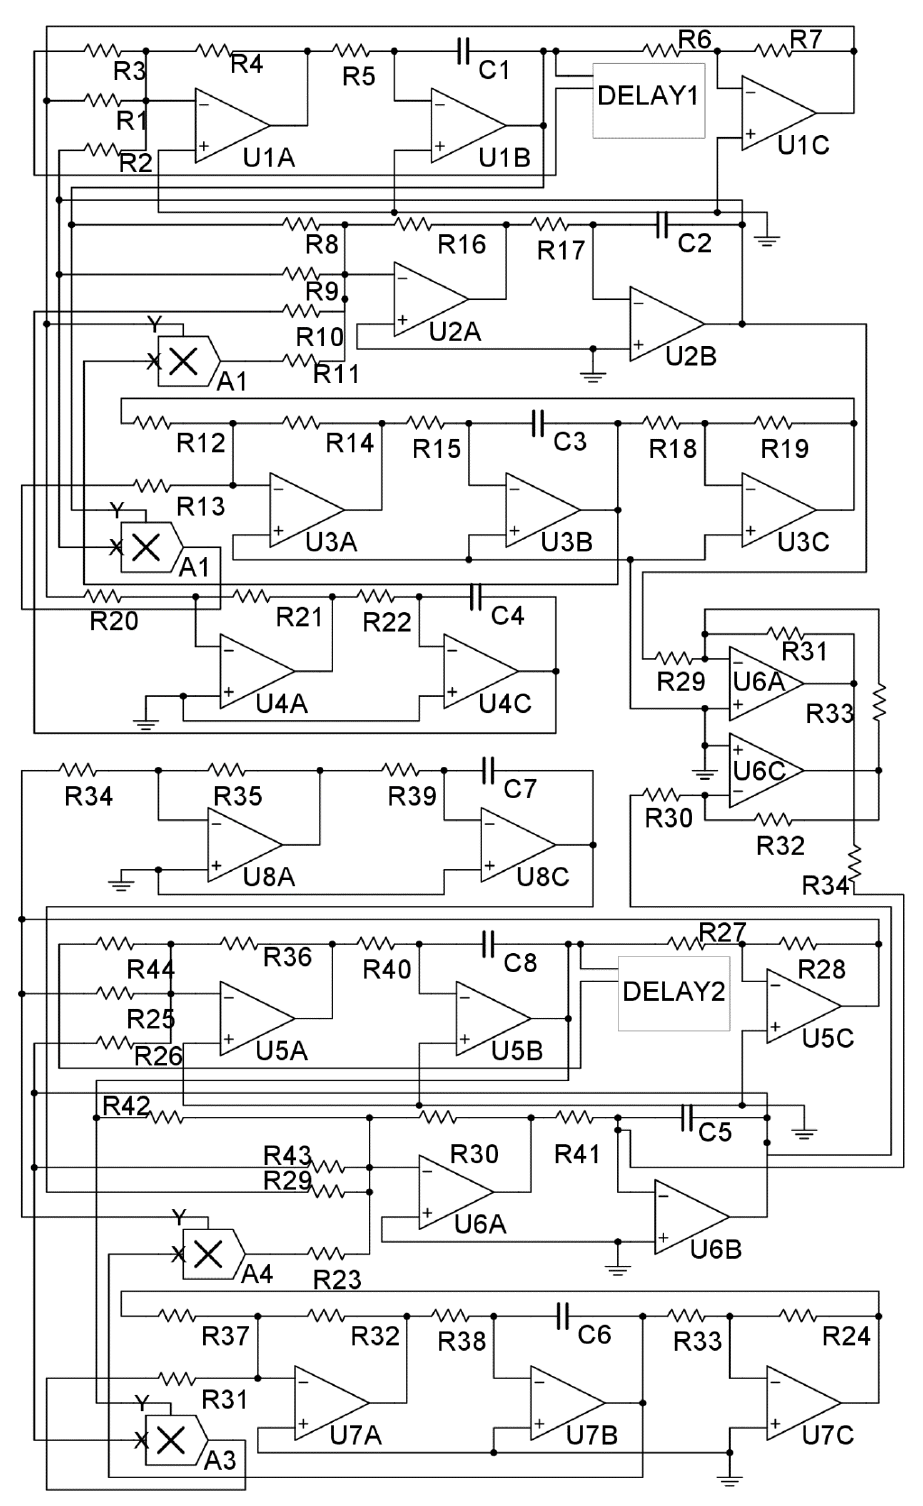
Figure 12. Constructed chaotic time-delay synchronous circuit.